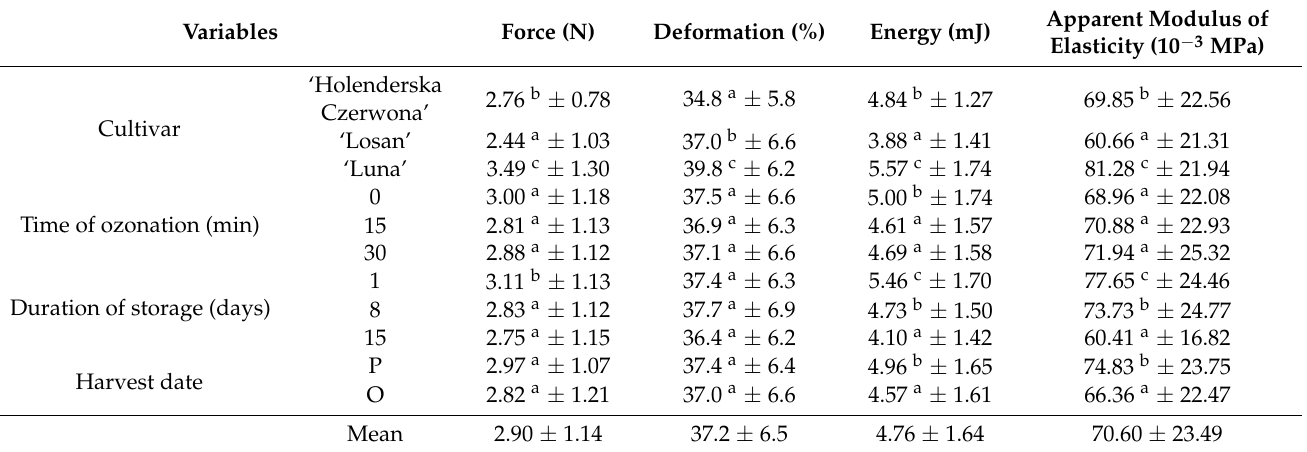
Table 2. Mechanical properties of red currant fruits depending on the variety, duration of storage, and time of gaseous